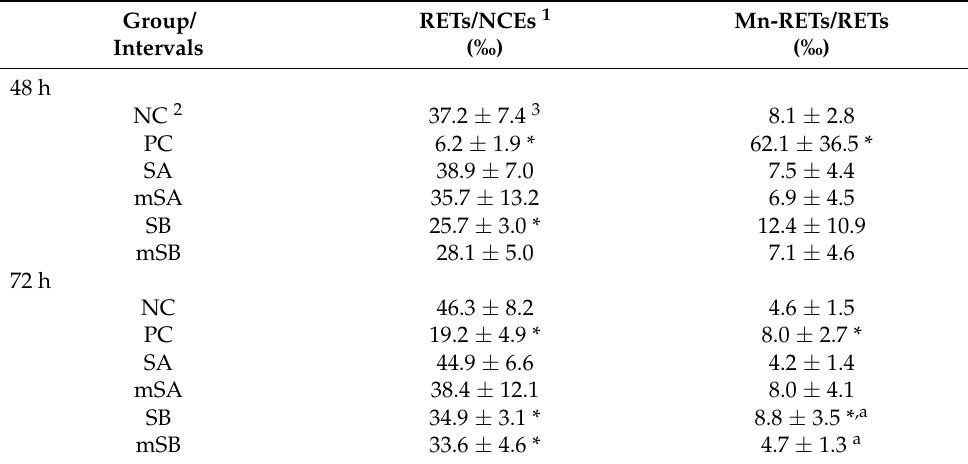
Table 8. Changes of reticulocytes with micronuclei in the peripheral blood of rats after intratracheal instillation with unmodified and modified nano-silica in the peripheral blood micronucleus